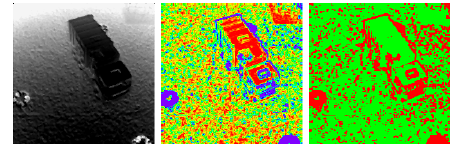
Figure 2: Range image, confidence map (pseudo-color represen- tation where reliable points are marked in red and unreliable ones in blue) and thresholded confidence map (green: σ ≤ 0 . 05